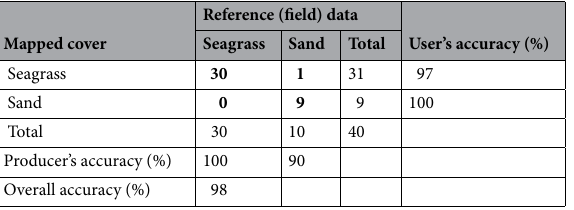
Table 1. Confusion matrix based on number of sites, and accuracy for the benthic cover